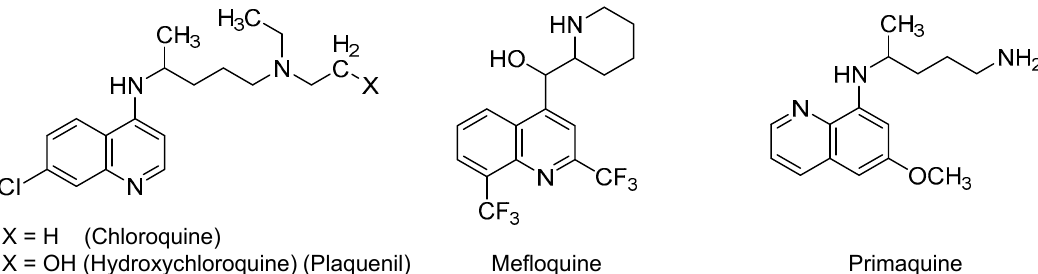
Figure 2. The chemical structures of quinoline-based antimalarial drugs that are being tested in COVID-19 patients.